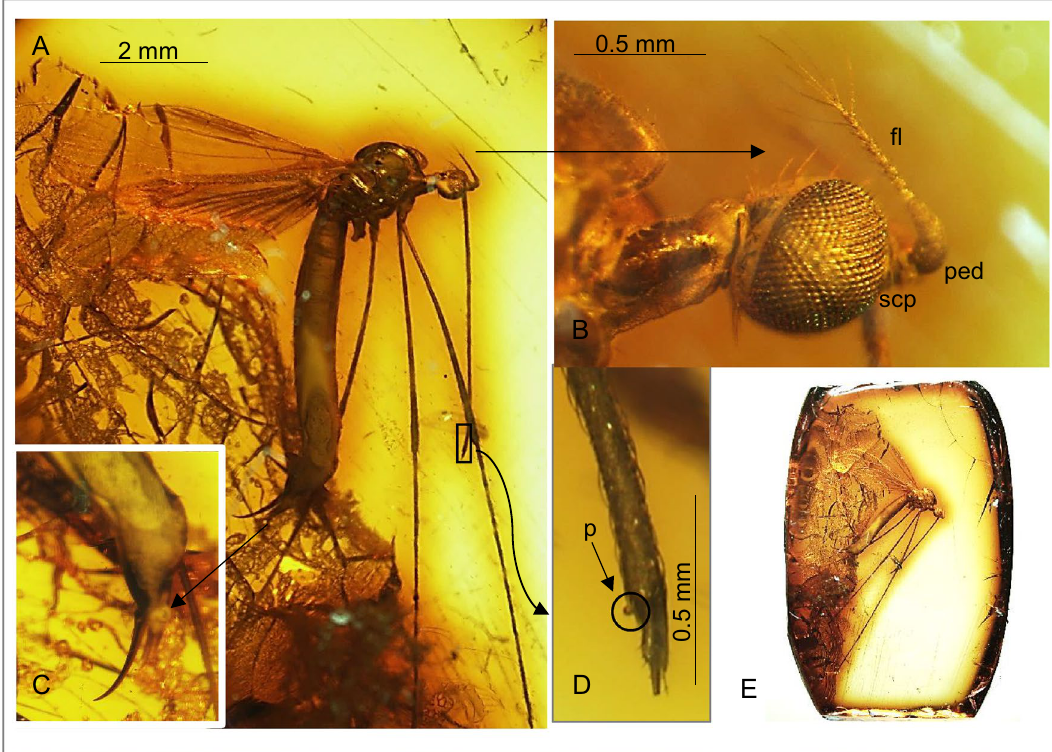
Figure 3. Toxorhina ( Ceratocheilus ) eridanus Meunier 4 (Limoniidae), inclusion in Baltic amber, specimen from Natural History Museum Humboldt University, Berlin (NHMB) (female): ( A ) body, lateral view; ( B ) enlarged view of head, lateral view; ( C ) enlarged view of ovipositor; ( D ) enlarged view of the tip of rostrum with palpus visible; ( E ) amber piece with habitus in lateral view. fl—flagellum; scp—scape; ped—pedicel;